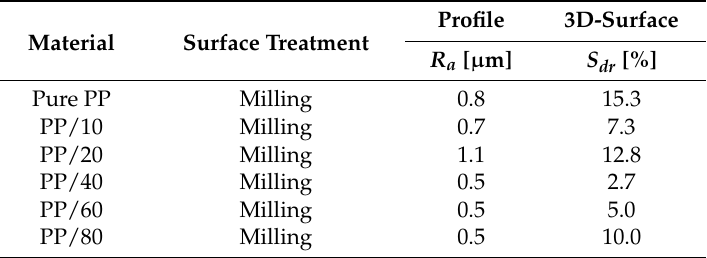
Figure 8. Graphical explanation of the R a profile factor. Table 4. Surface roughness expressed using 2D profile and 3D surface